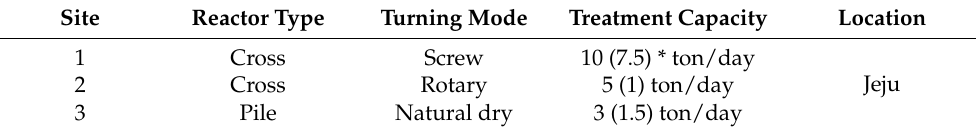
Table 1. Profile of swine manure composting plants investigated in this study. Site Reactor Type Turning